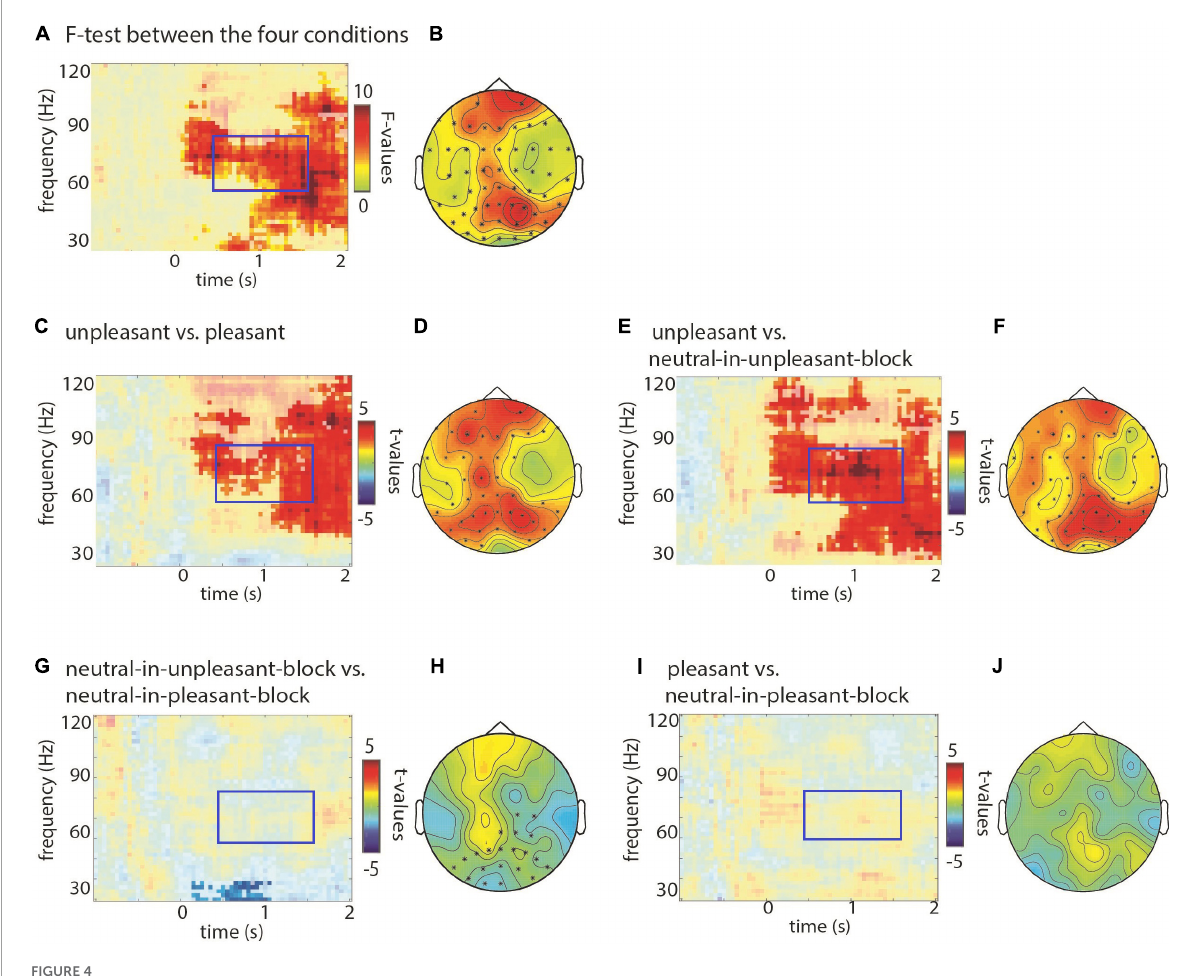
FIGURE4 Modulations at higher frequencies with respect to valence of the pictures. Time-frequency representations of power when comparing conditions ( F/t -statistics), masked for significance, at sensor Pz. Topographical representations are based on averaged data for the latency 0.5–1.5 s and a frequency range from 60 to 80 Hz. Significant sensors are displayed with an asterisk in the topographical representation. (A) The F -test revealed that gamma power was differently modulated by conditions ( p < 0.05; controlled for multiple comparison). (B) Topographical representation for the effect shown in panel (A) revealed posterior and anterior modulation. (C,D) A stronger increase in gamma power was observed posteriorly and anteriorly for unpleasant compared to pleasant pictures. (E,F) Similarly, for unpleasant compared to neutral-in-unpleasant-block a strong increase in gamma power was observed, mainly over posterior sensors. (G,H) When comparing neutral pictures of the unpleasant and pleasant blocks, a gamma decrease at the lower frequencies around 30–40 Hz for neutral-in-unpleasant block became apparent. (I,J) No significant difference for pictures of the pleasant vs. neutral-in-pleasant-block was